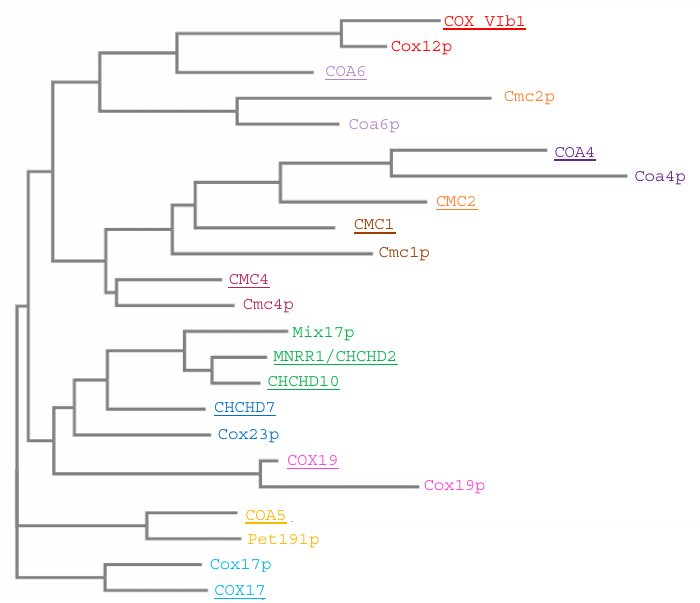
Figure 12. Sequence similarity of twin CX 9 C proteins. Human and yeast protein sequences were aligned using MUSCLE, phylogenetic tree created with PhyML and TreeDeign (“One Click” MAB LIRMM). Homologs/orthologs between species are colored the same. Human proteins are under- lined.